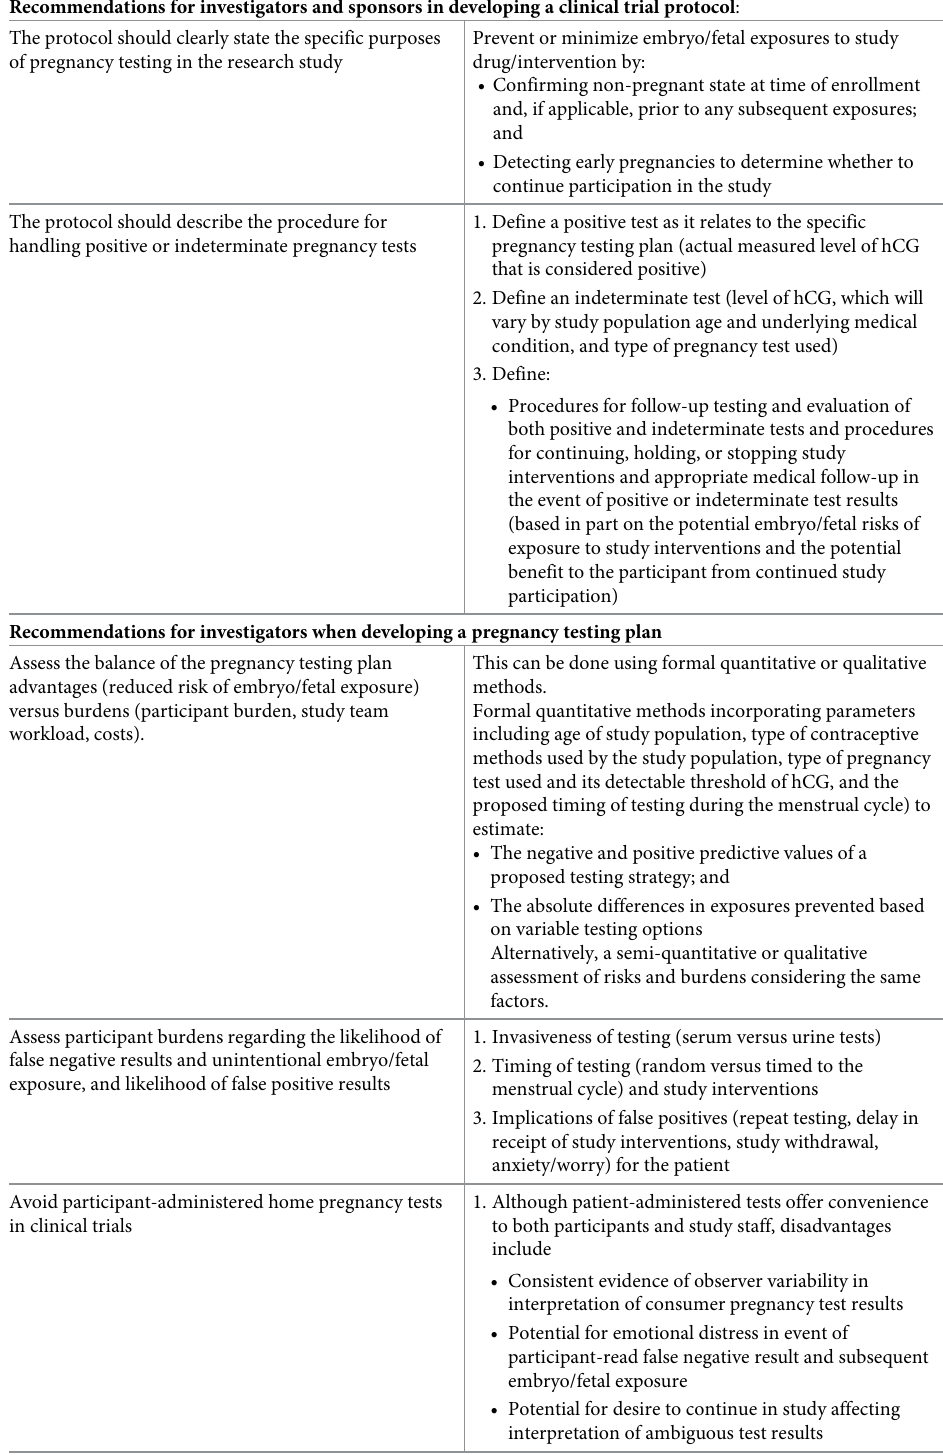
Table 4. Specific recommendations for pregnancy testing in clinical trials. Recommendations for investigators and sponsors in developing a clinical trial protocol